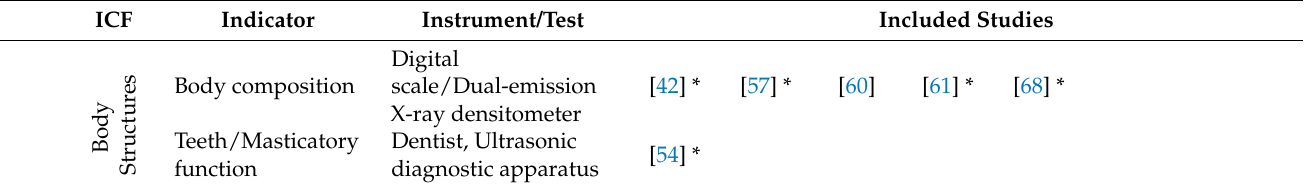
Table 2. A summary of objective and subjective measures with a significant association with age according to the included study (quality classification ≥ fair); studies of fair quality are indicated with a *, and the others correspond to studies of good